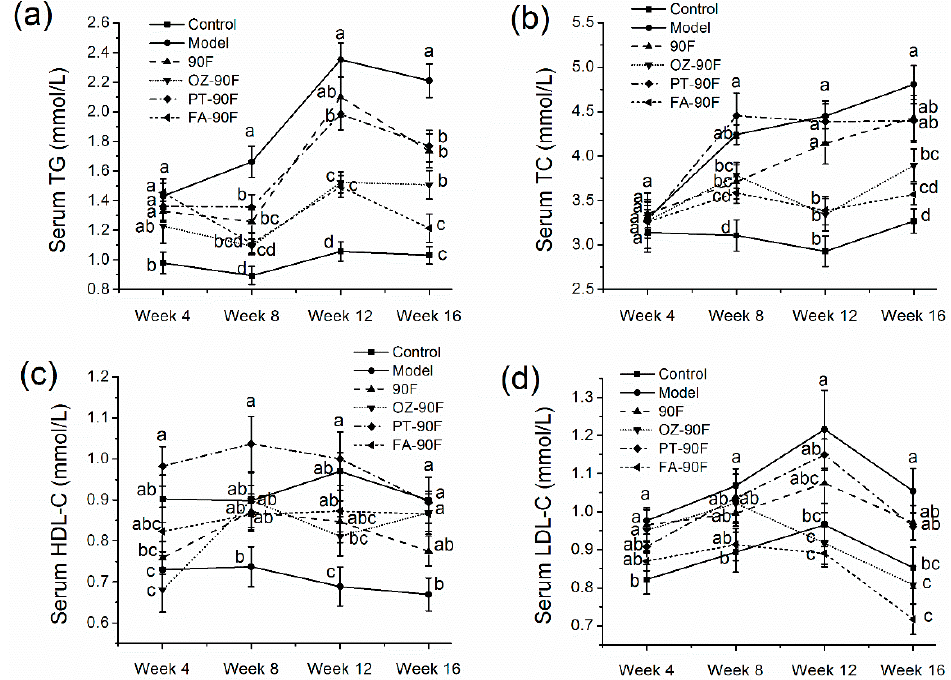
Figure 3. Effect of enriched flour on serum lipid profiles in rats. Blood samples were collected from orbital venous at week 4, 8, 12 and 16 from 12 h fasted rats. ( a ) Serum TG level; ( b ) serum TC level; ( c ) serum HDL-C level; ( d ) serum LDL-C level. Data are presented as mean ± SEM ( n = 10). Mean values from the same week with different letters are significantly different ( p < 0.05). 90F, 90% wheat flour; OZ-90F, γ -oryzanol enriched 90% wheat flour; PT-90F, phytosterol enriched 90% wheat flour; FA-90F, ferulic acid enriched 90% wheat flour.